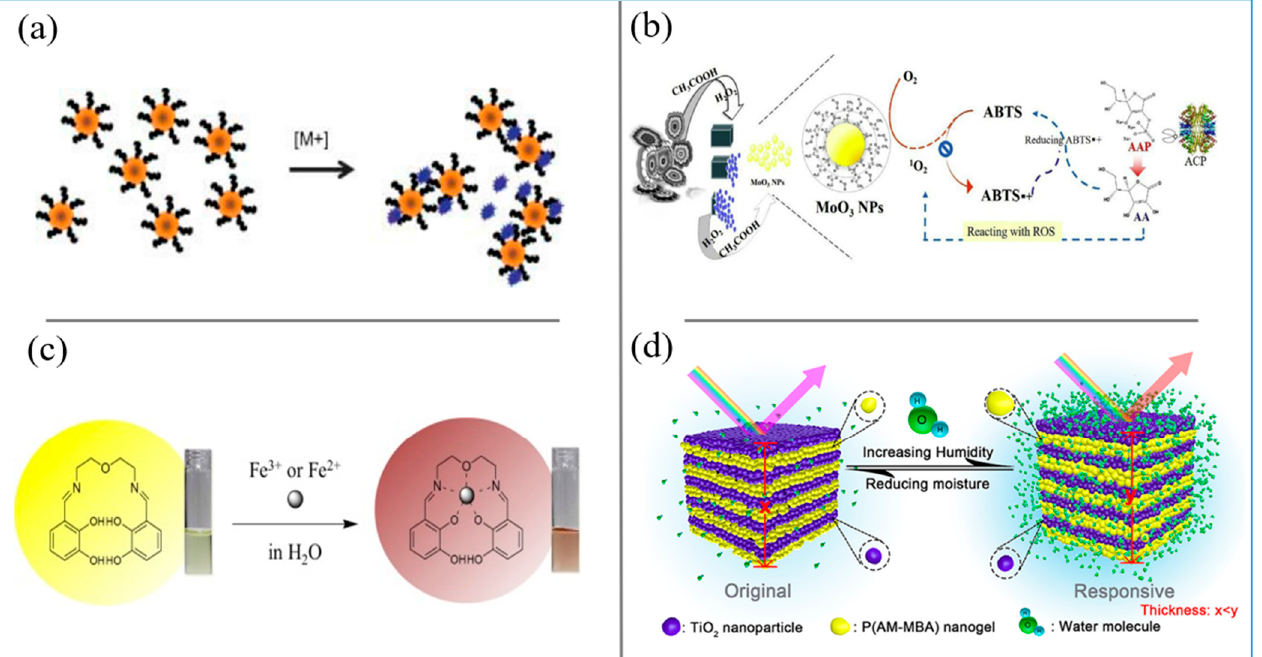
Figure 1. ( a ) Schematic illustration of the aggregation of peptide-functionalized nanoparticles (PFNs) in the presence of metal ions [M+]. Reprinted with permission from Ref. [33] , Copyright 2008, Wiley-VCH. ( b ) Principle of ACP determination based on the oxidase-mimicking property of MoO 3 NPs. Reprinted with permission from Ref. [35] , Copyright 2020, Elsevier. ( c ) Colorimetric Detection Mechanism of chelated Schiff base for Fe 2+ and Fe 3+ . Reprinted with permission from Ref. [36] , Copyright 2015, Elsevier. ( d ) Illustration of response of the 1DPC sensor to water vapor: the original 1DPC and the responsive 1DPC. Reprinted with permission from Ref. [37] , Copyright 2018 American Chemical Society.